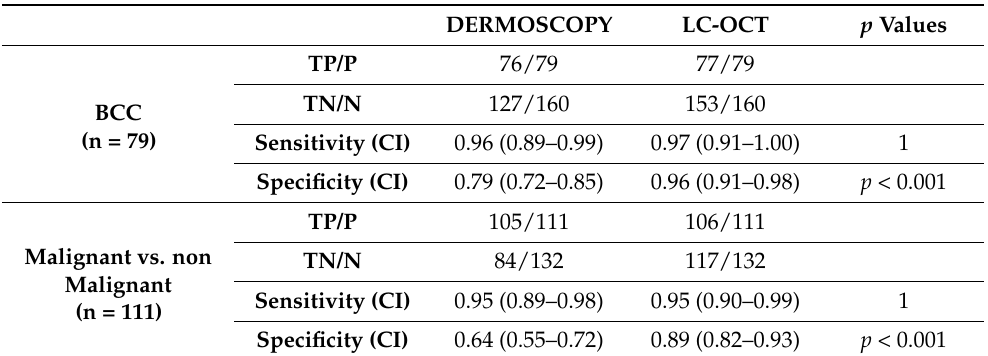
Table 3. Sensitivity and specificity of dermoscopy and LC-OCT considering histology and follow- up